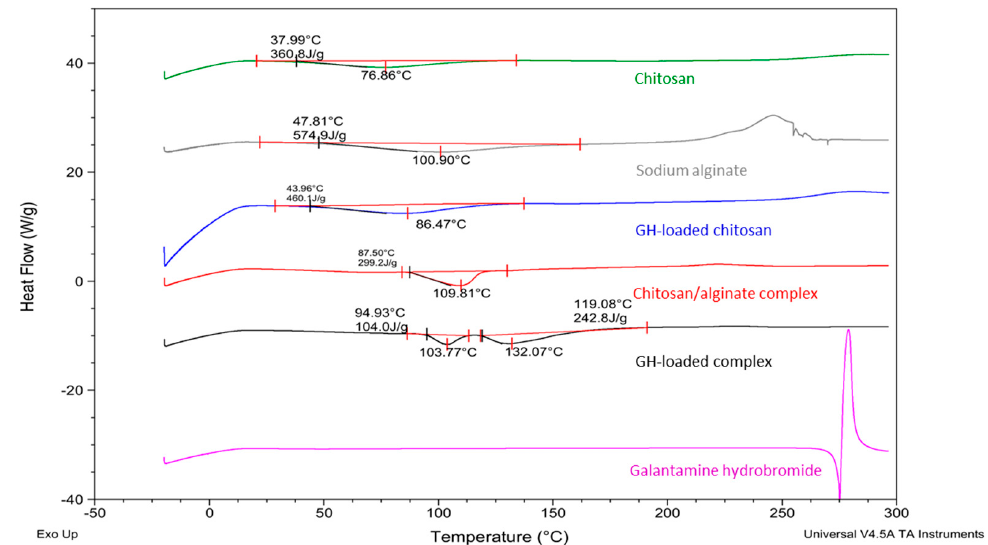
Figure 4. DSC thermograms of chitosan, sodium alginate, GH, GH-loaded samples, and chitosan/alginate complexes. Table 2. Water contents in pure and drug-loaded samples as well as in their constituents.